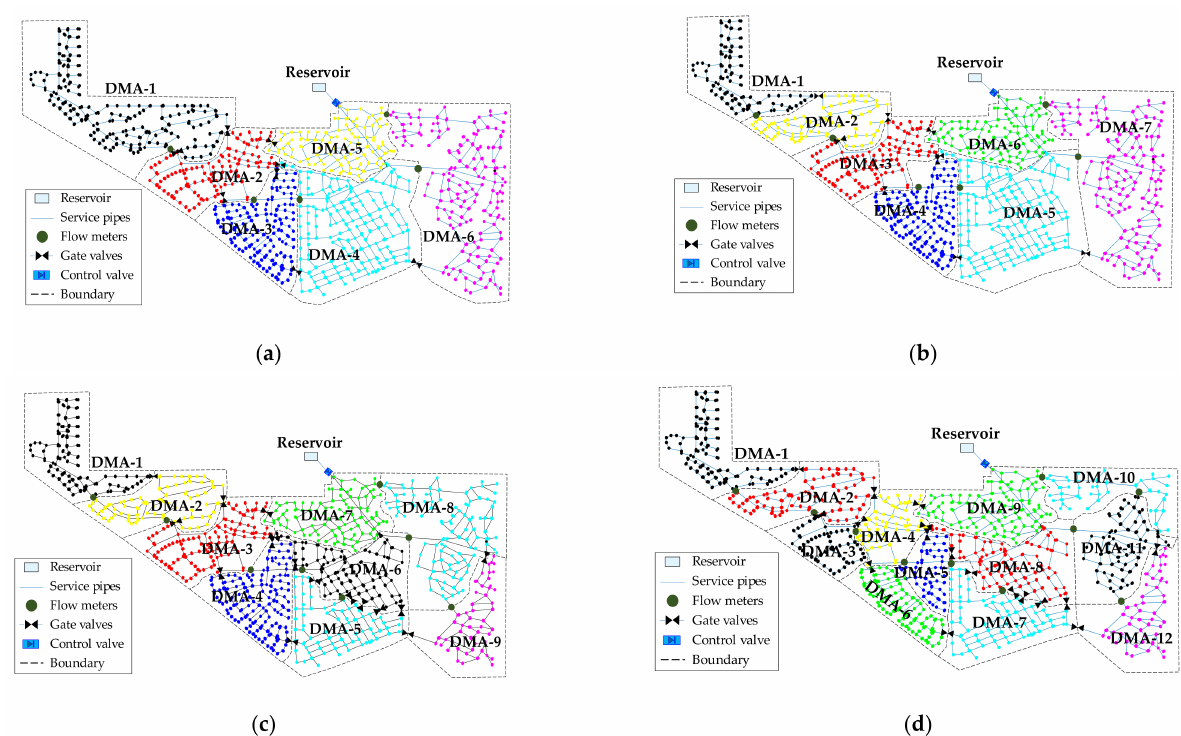
Figure 9. Sample of DMA layouts generated: ( a ) 6 DMAs; ( b ) 7 DMAs; ( c ) 9 DMAs; ( d ) 12 DMAs. Table 4. Characteristic of boundary pipes obtained by GA for different DMA layouts. No. of